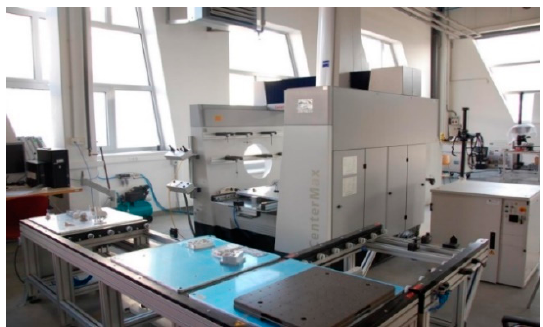
Figure 5. Coordinate measuring machine ZEISS CenterMax [34], as also cited in [25].